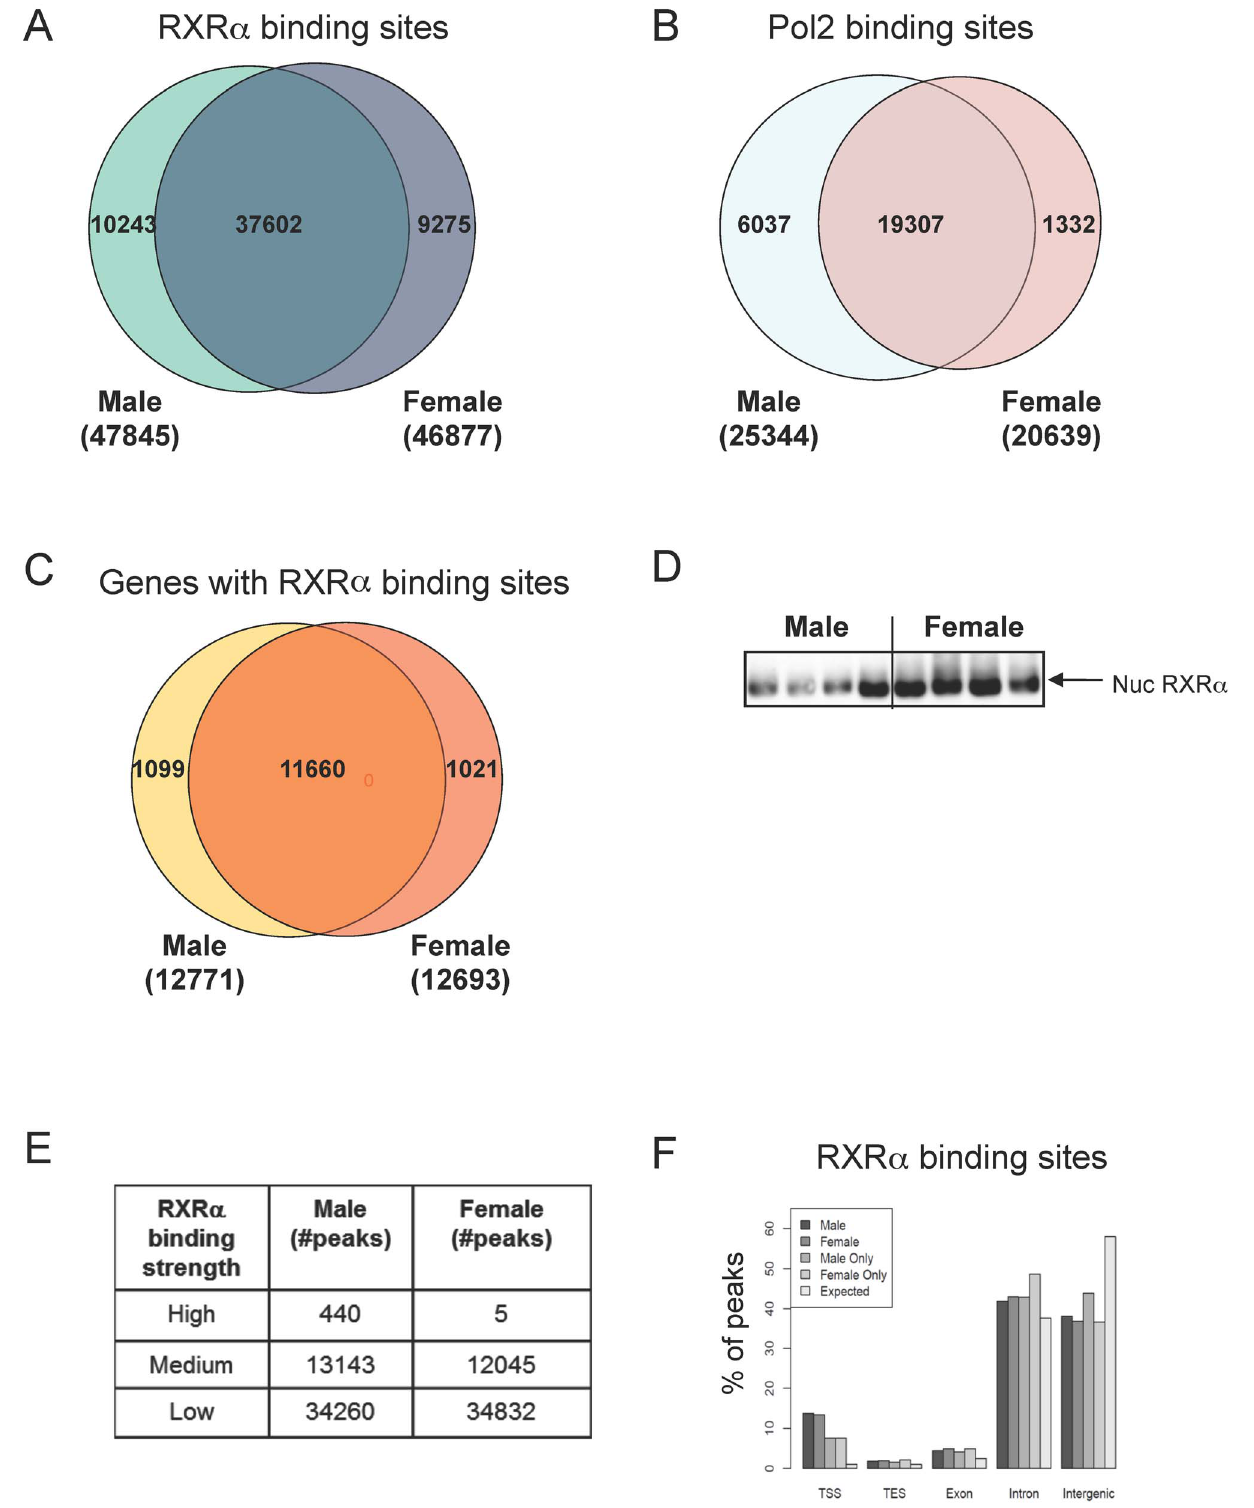
Figure 1. Genome wide mapping of RXR a and Pol2 binding sites in male and female mouse liver. A) Venn diagrams show number of RXR a binding sites in male and female livers with 37602 binding sites shared between genders, and 10243 unique RXR a male and 9275 unique RXR a female binding sites (see also Table S1A and S1B in File S1). B) Venn diagrams show number of Pol2 binding sites in male and female livers, with 19307 binding sites shared between genders, and 6037 unique male and 1332 unique female Pol2 binding sites. C) Venn diagrams representing number of genes associated with RXR a peaks shown in A), with 11660 genes shared between genders, and 1099 unique genes for male and 1021 genes for female. D) Western blot analysis shows increased nuclear RXR a protein levels in female mouse liver compared to male mouse liver. E)